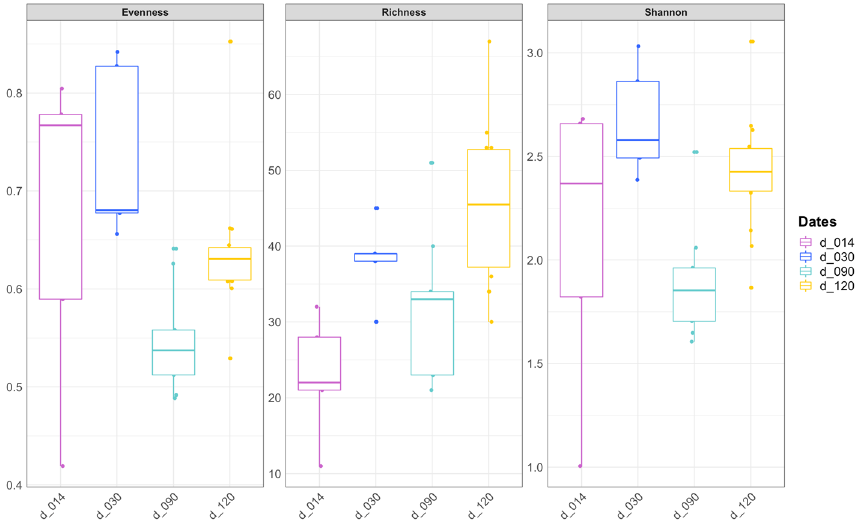
Figure 1. Evenness, observed species richness and Shannon index for fish specimens collected at the different dates (d14, d30, d90 et d120).